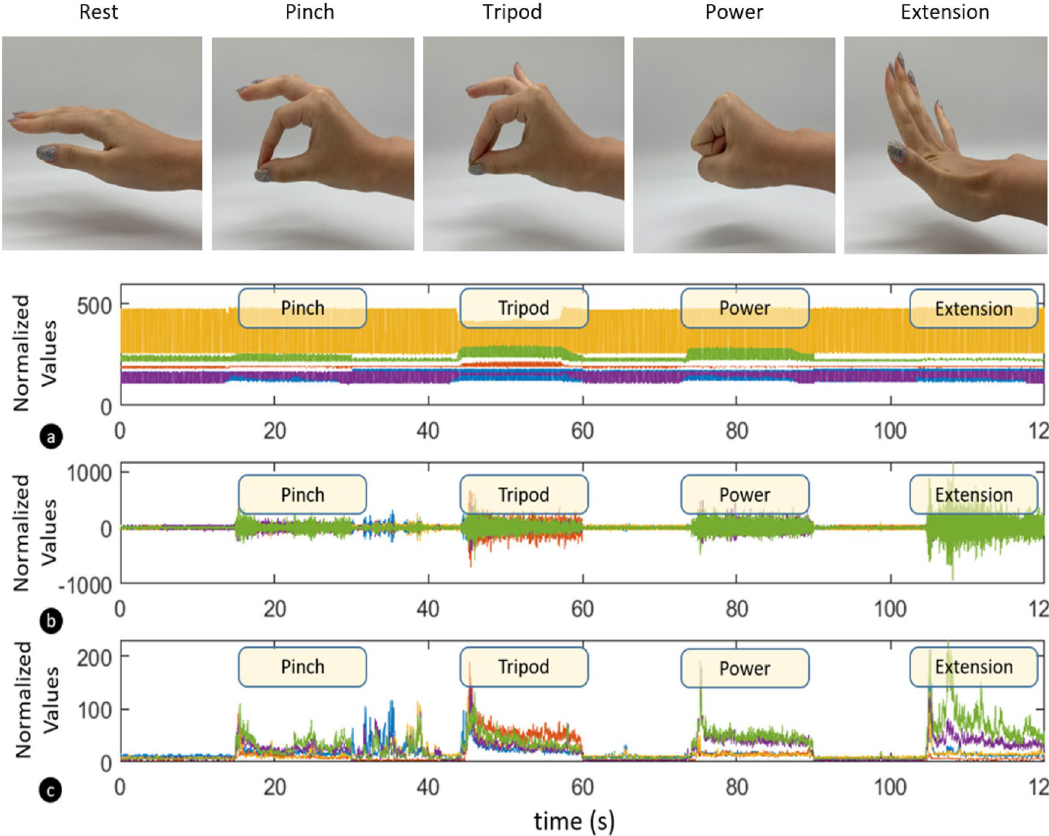
Figure 4. Normalised LMG and EMG measurements during pinch, tripod, power, and extension gesture. ( a ) shows the activation values for the LMG sensors, ( b ) shows the raw EMG activations, while ( c ) shows a feature extracted value (Root Mean Square - RMS value) of the EMG